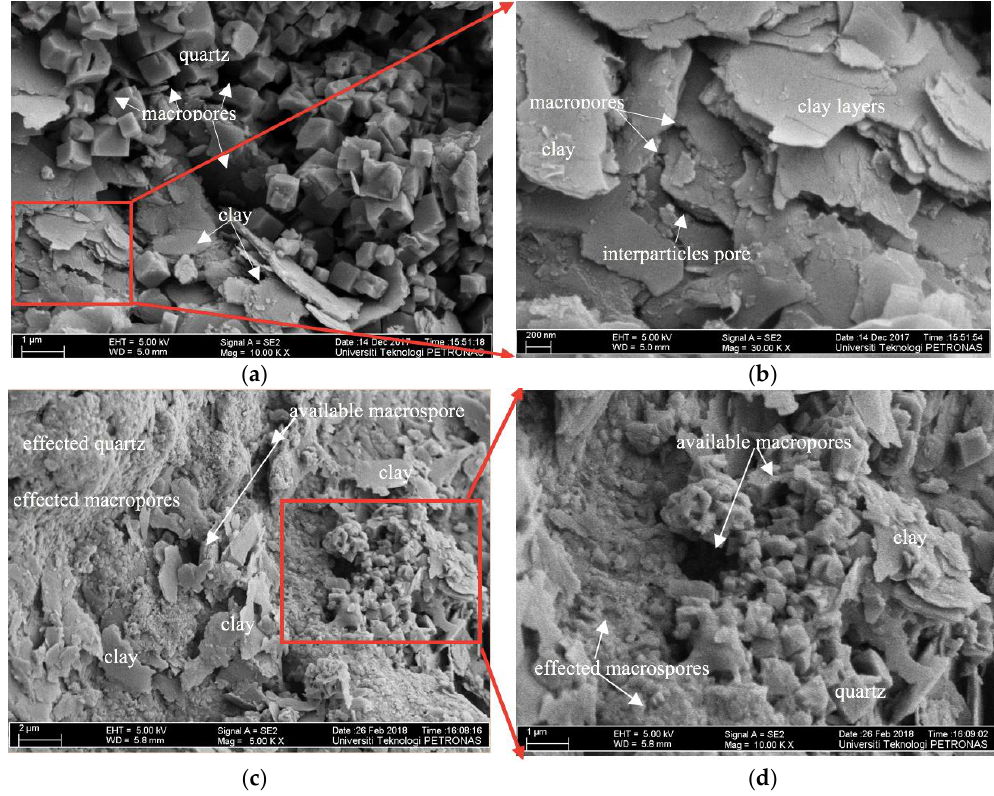
Figure 8. FE-SEM images of BG shale sample. ( a ) BG untreated sample at 10K magnification shows several macropores clays layers and quartz; ( b ) BG untreated shale sample at 30K magnification shows interparticle and intraparticle pores mesopores and confirmed the presence of clay layers; ( c ) BG water immersed sample at 5K magnification showed a water block effect on pores and change in the physical properties of shales, some interparticle macropores remained unblocked; ( d ) BG treated sample at 10K magnification showed blocked macropores and a few remained unblocked.